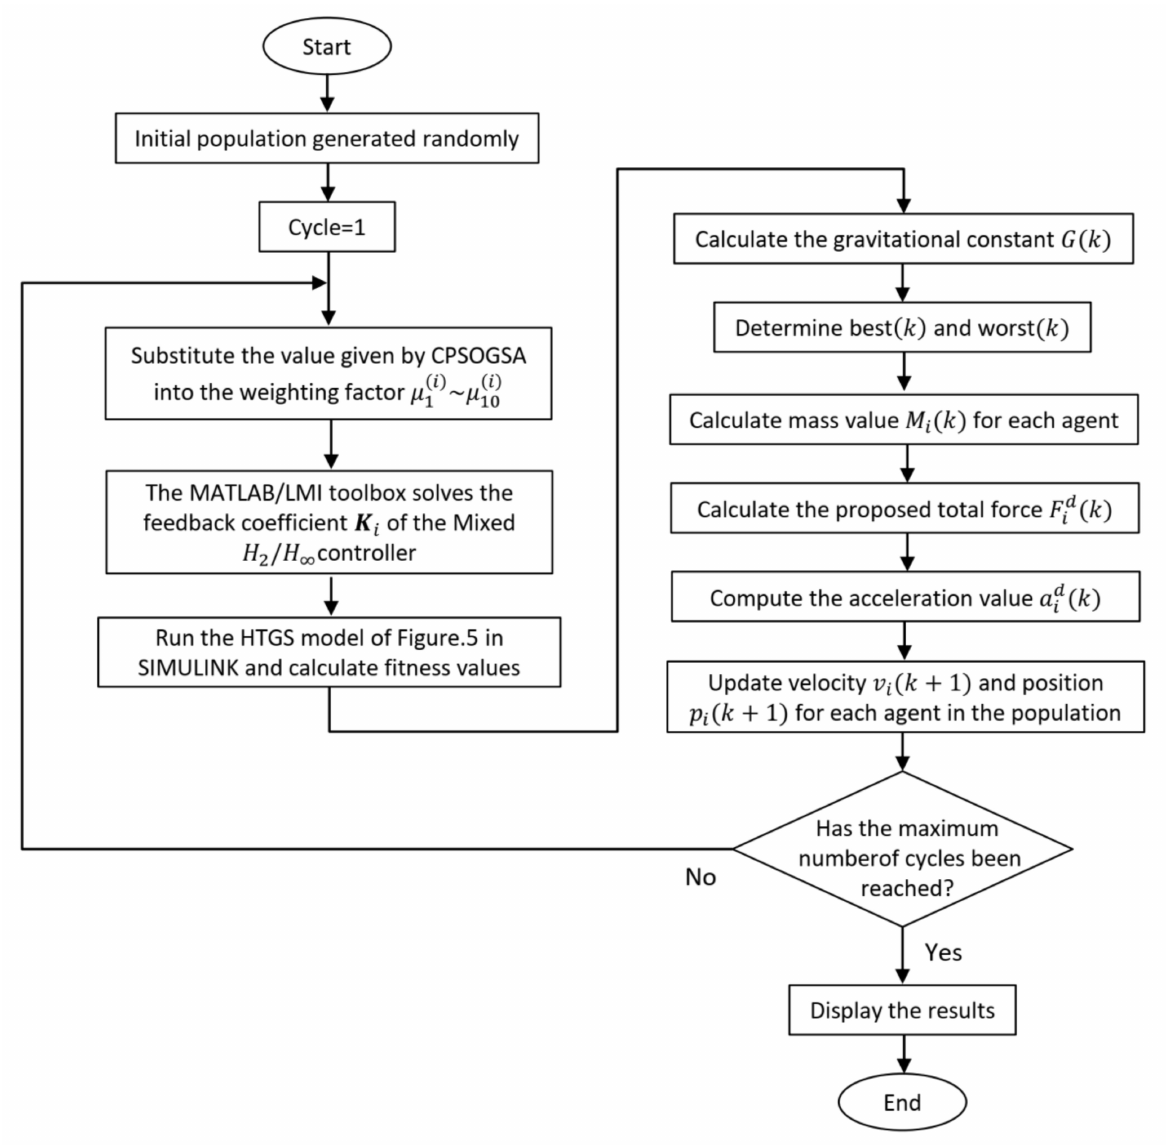
Figure 6. Solution process of CPSOGSA